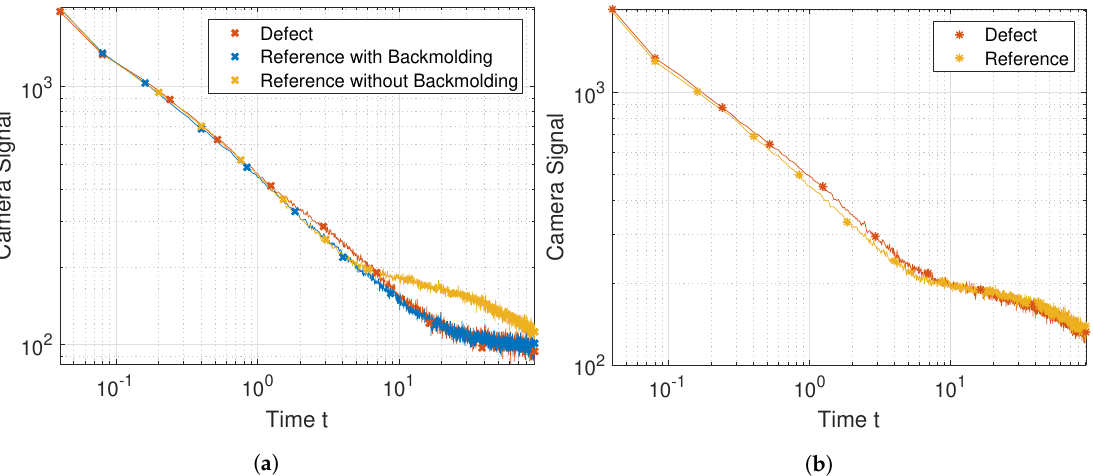
Figure 7. Experimental results: ( a ) measured temperature–time sequences (crosses in Figure 6a) and ( b ) measured temperature–time sequences (asterisks in Figure